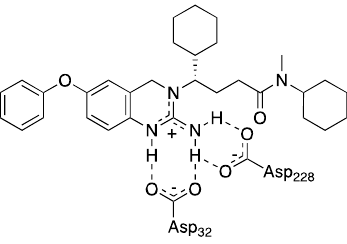
Figure 1. Baxter’s inhibitor and network of hydrogen bonds with the BACE-1 catalytic diad.